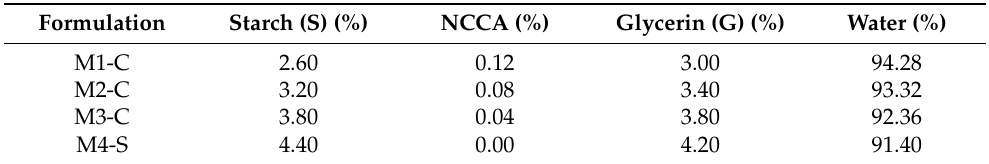
Table 1. Formulation of biodegradable